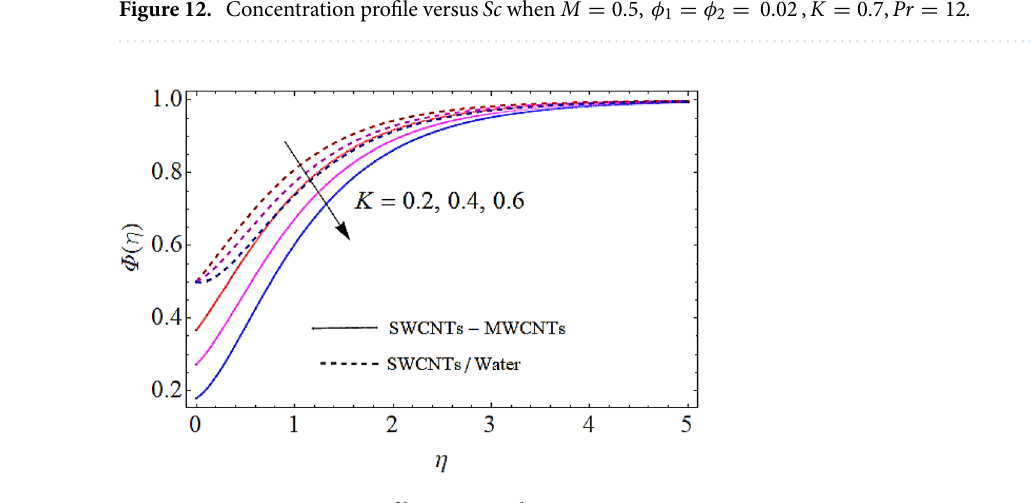
Figure 13. Concentration profile versus K when M = 0.5, φ 1 = φ 2 = 0.02, Sc = 0.7, Pr = 12 .